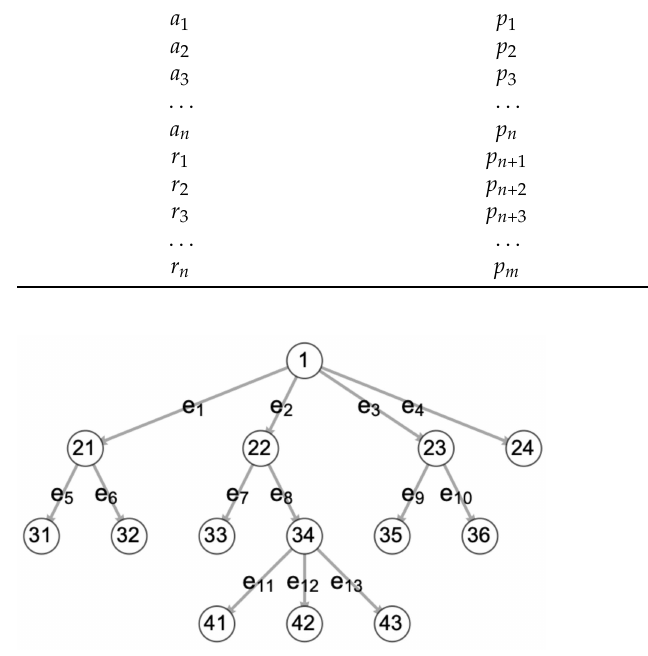
Figure 1. Cartoon robot behavior tree (BT) with typical numbering of vertices and edges (after Iovino et al. [55], Figure 2), as a minute portion of a large and complex AGI behavior control